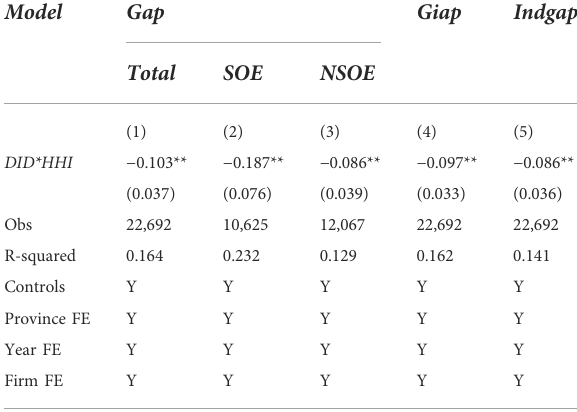
TABLE 8 Market competition mechanism estimation